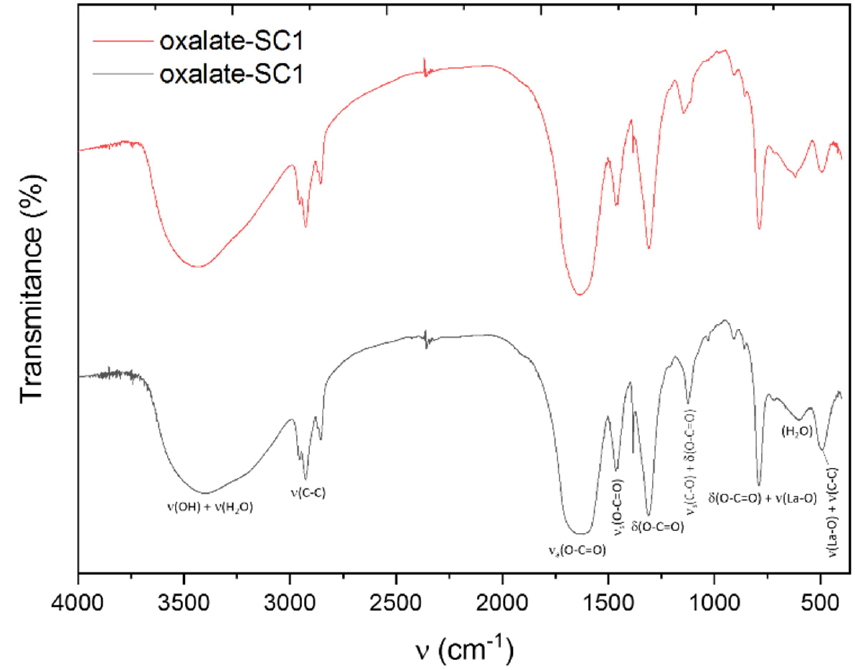
Figure 9. FTIR spectrum of the obtained oxalates.